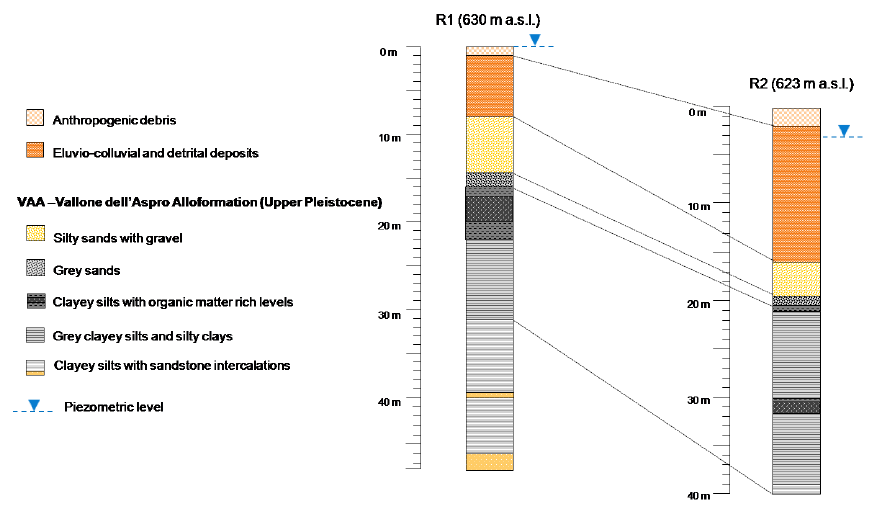
Figure 11. Main stratigraphic features of the logs reconstructed along the R1 and R2 boreholes, showing a sequence of sandy and silty sediments resting on clayey silts with blackish peaty levels.